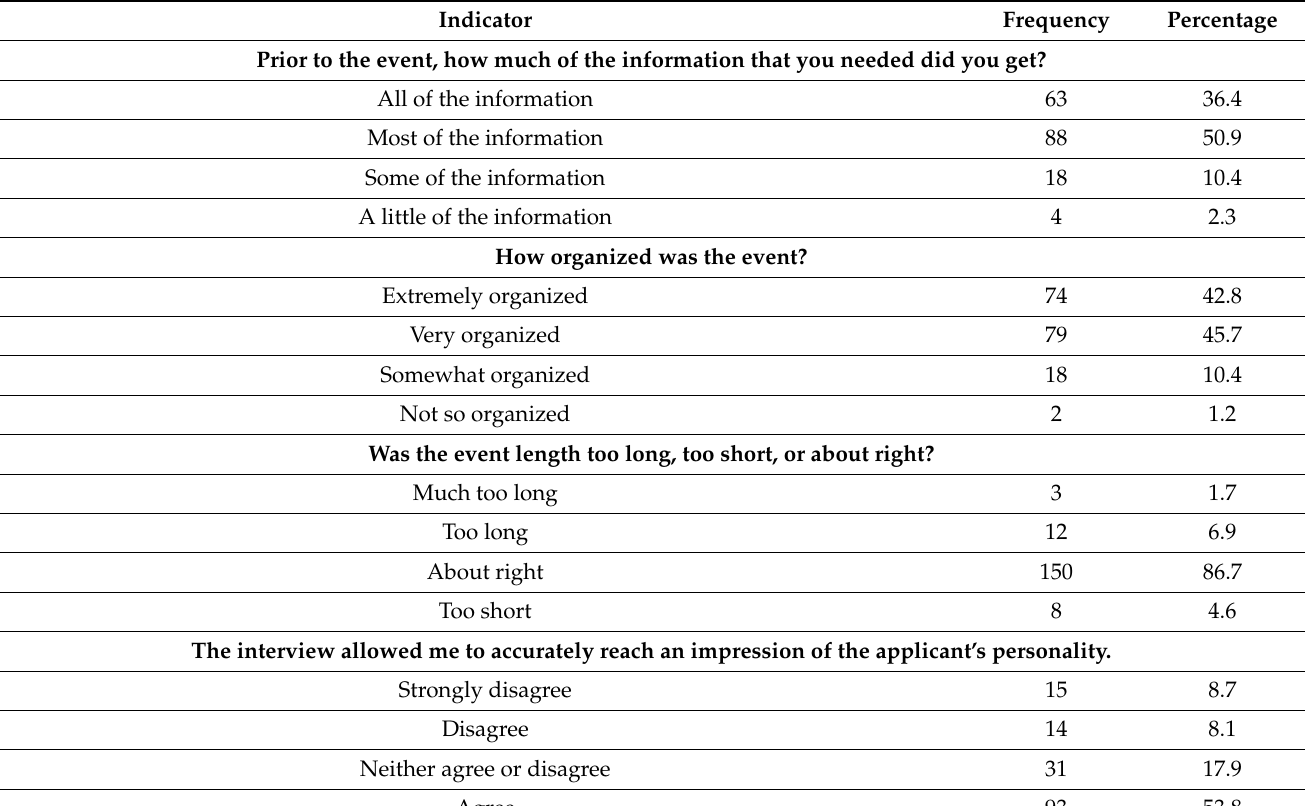
Table 2. Faculty members’ indicators of satisfaction with virtual interviews